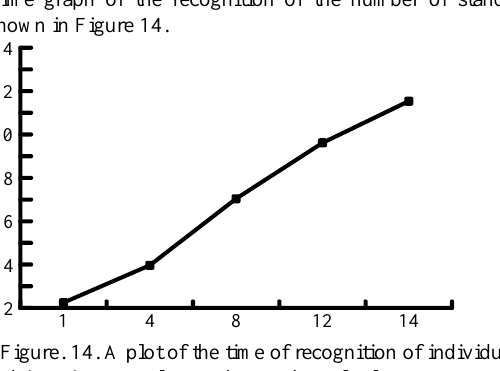
Figure. 14. A plot of the time of recognition of individual flat objects in a complex on the number of references to an object Analysis of the graphs in Figure. 12-14 shows that the maximum error rate of recognition of individual objects in the complex plane based on the A-function in a plurality of reference is: at 4 standard - 5.5%; time -3.968 ms; etalons at 8 - 2%; time - 7.038 ms; at 12 or more etalons - 0%; time - 9.615